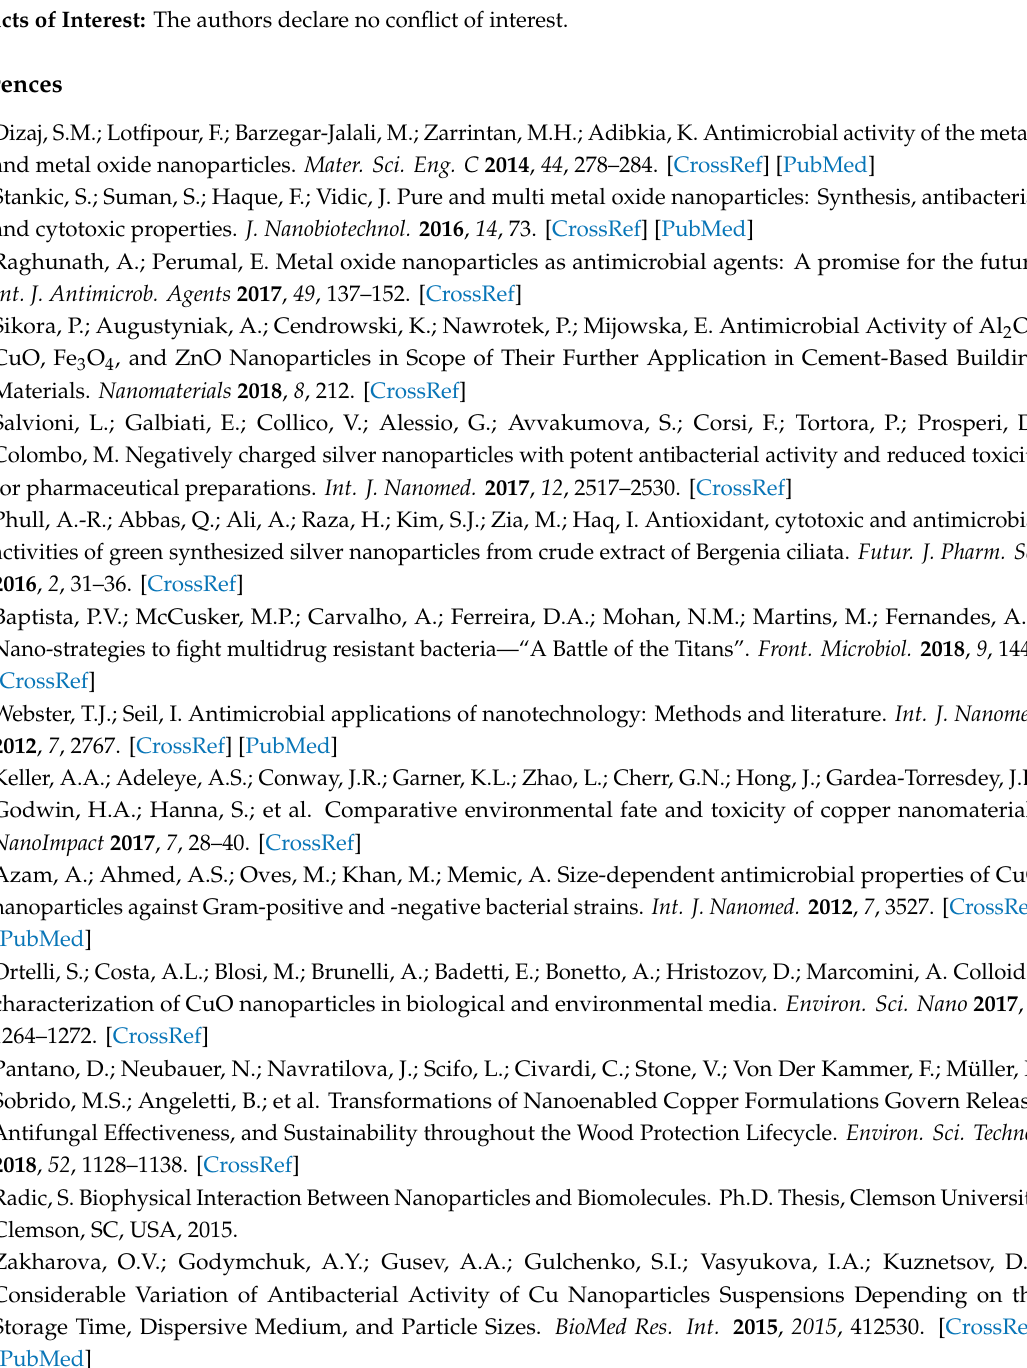
Table S1: Infrared band assignment of free amino acids (Leu, Glu, Asp, Tyr, Phe, Cys) and CuO NPs treated with Leu, Glu, Asp, Tyr, Phe and Cys, according to the literature, Table S2: TG and DSC analysis